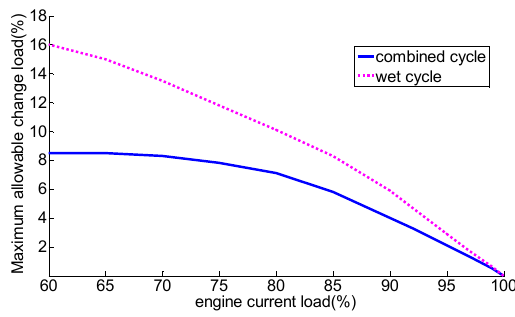
Figure 7. Maximum allowable change load for STIG cycle vs.